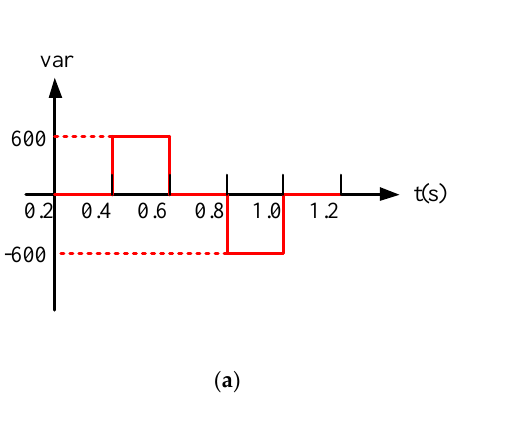
Table 3. Equivalent values of control signals.